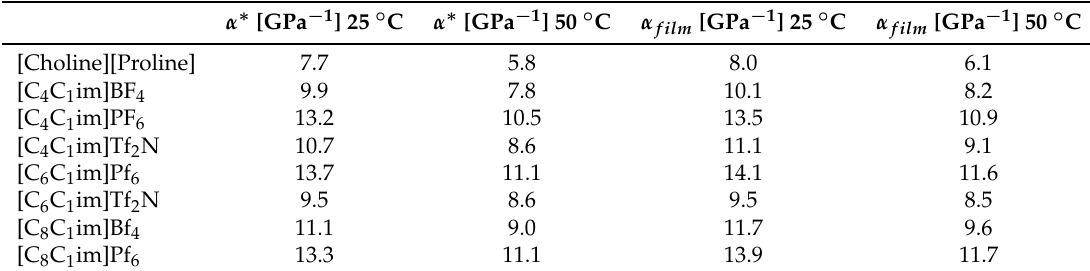
Table 4. Comparison of pressure-viscosity